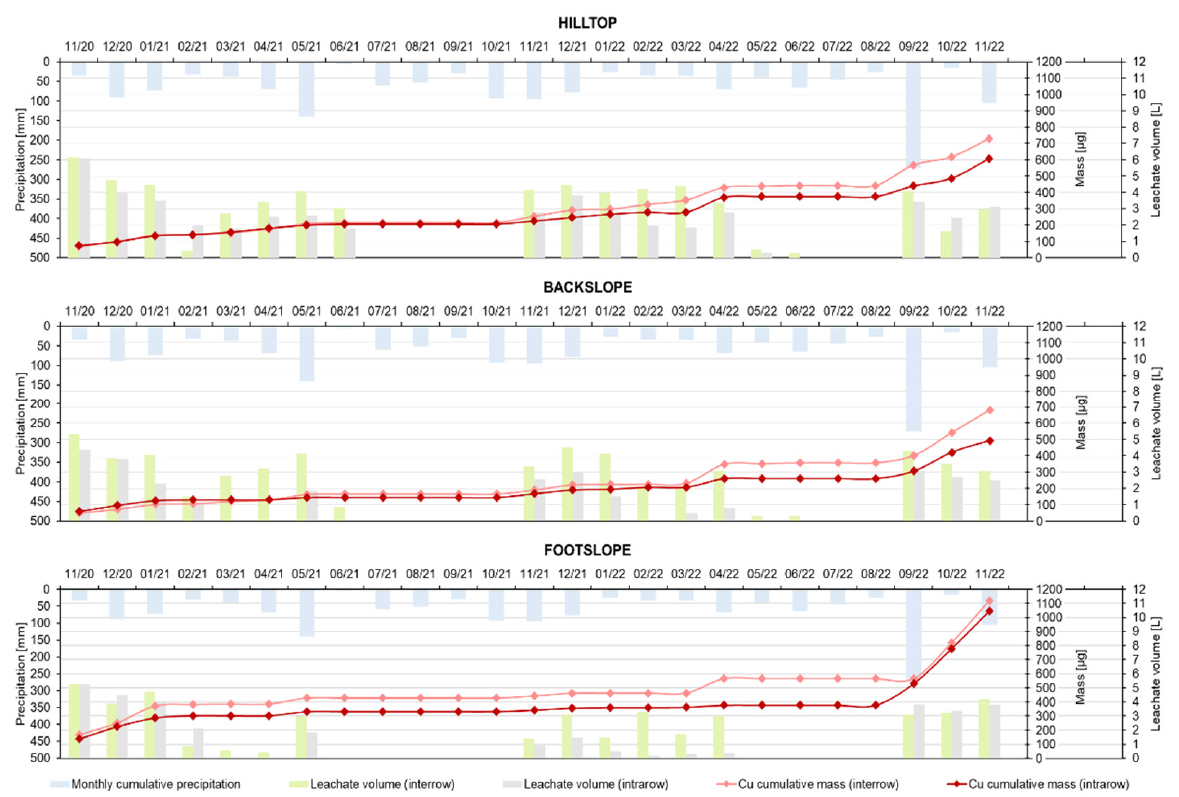
Figure 5. Copper (Cu) cumulative mass ( µ g) in leachates, collected for two years (2 November 2020–25 November 2022), from lysimeters installed at hilltop, backslope and footslope of vineyard inter- and intra-row, presented with monthly cumulative precipitation and leachate volumes per sampling event.